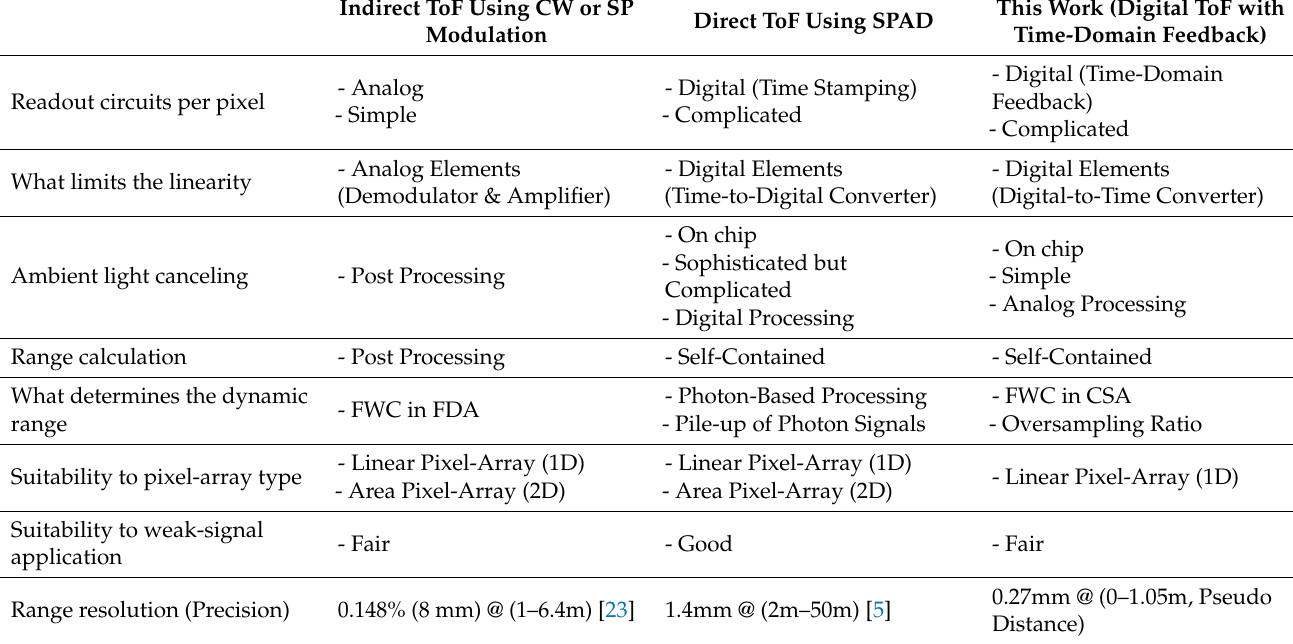
Table 2. Comparison of ToF Sensor